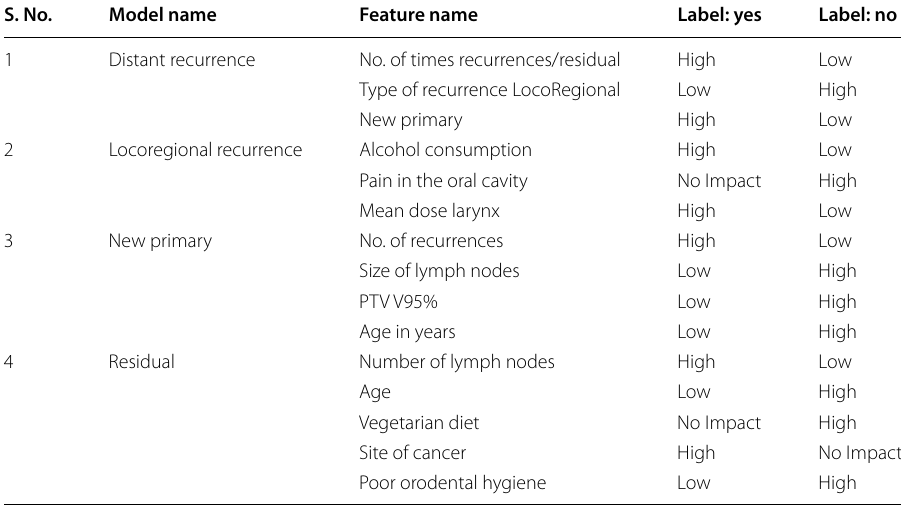
Table 4 List of common features selected by Shapely